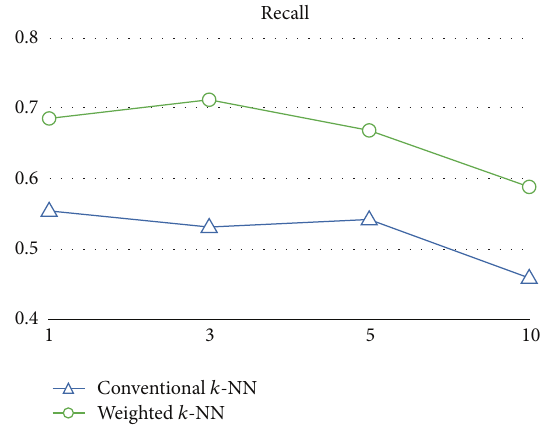
Figure 9: Recall of the conventional 𝑘 -NN classifier and the weighted 𝑘 -NN classifier on different 𝑘